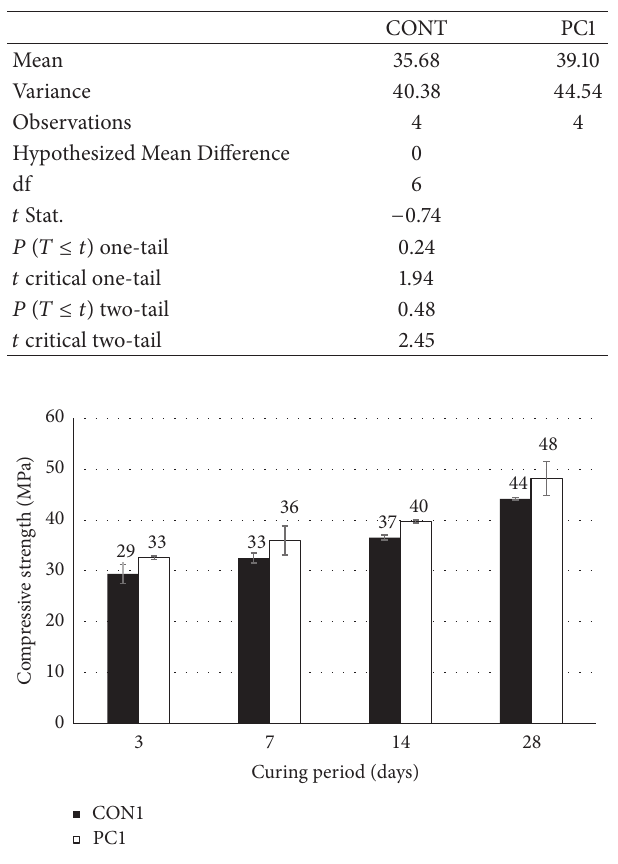
Table 5: 𝑡 -test on compressive strength of cements assuming unequal variances.